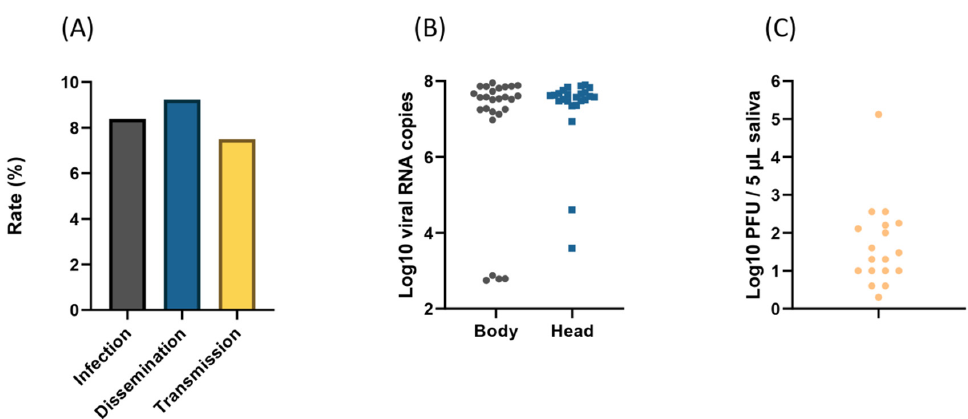
Figure 2. Infection, dissemination, and transmission rates ( A ); viral RNA copies in the body and head ( B ); and viral particles in saliva ( C ), 21 days after challenging Culex pipiens s.l. with West Nile virus at a titer of 10 7.3 pfu/mL.